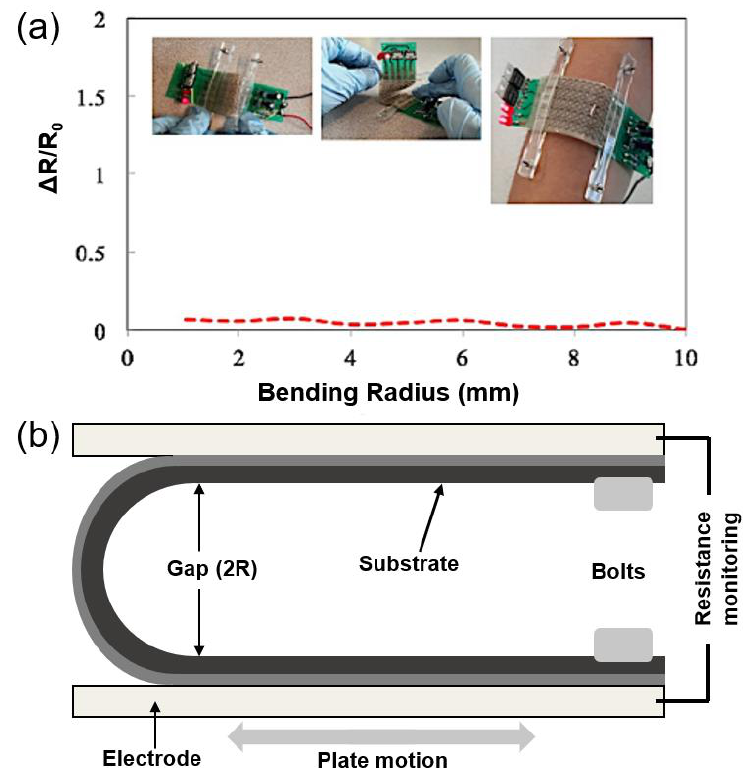
Figure 11. ( a ) Conductivity of Ag NW electrode at various bending radii. (Inset: left (inter-connection bent), middle (inter-connection twisted), right (inter-connected PCB assembly on the arm). Reproduced with permission from [64]. Copyright 2014 WILEY-VCH Verlag GmbH and Co. ( b ) Schematic of a cyclic bending fatigue tester [65].